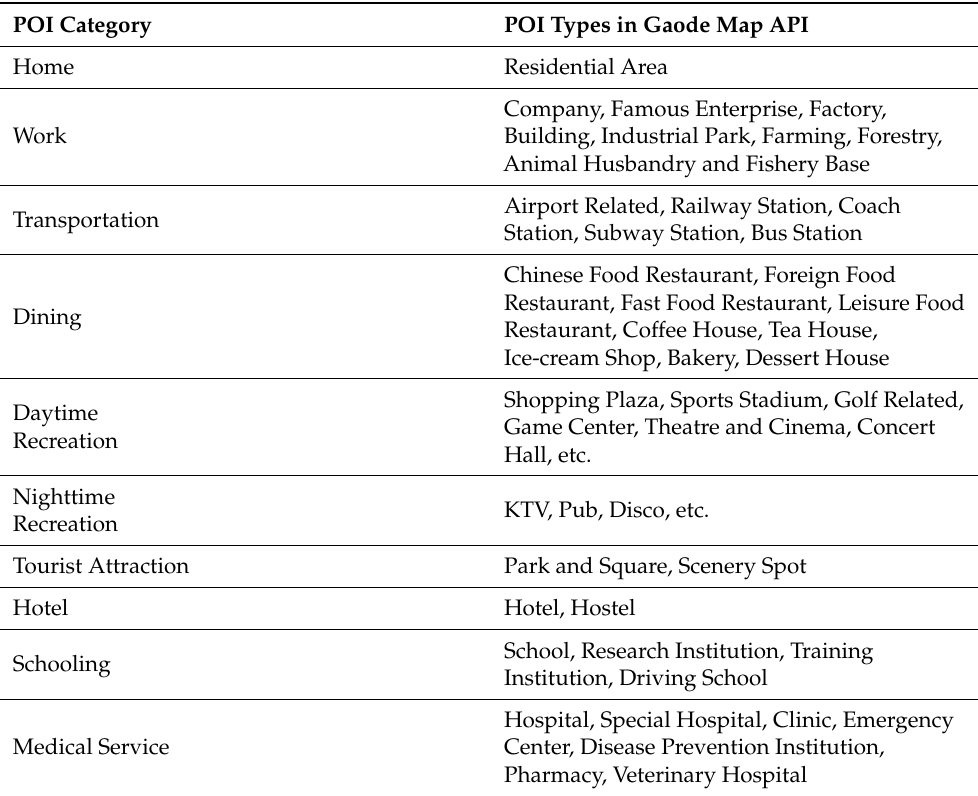
Table 2. POI category